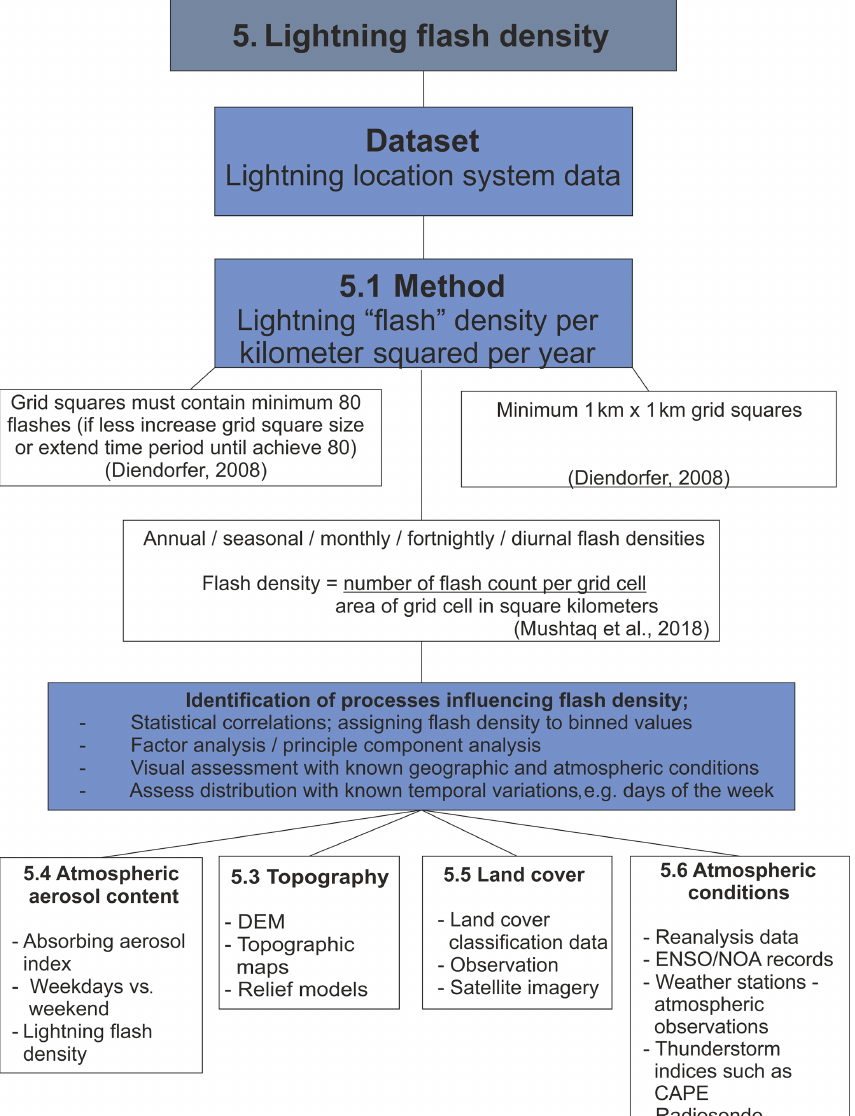
Figure 4. Diagrammatic summary of the steps involved in producing a lightning flash density thunderstorm climatology, showing the different variables to consider during the study design